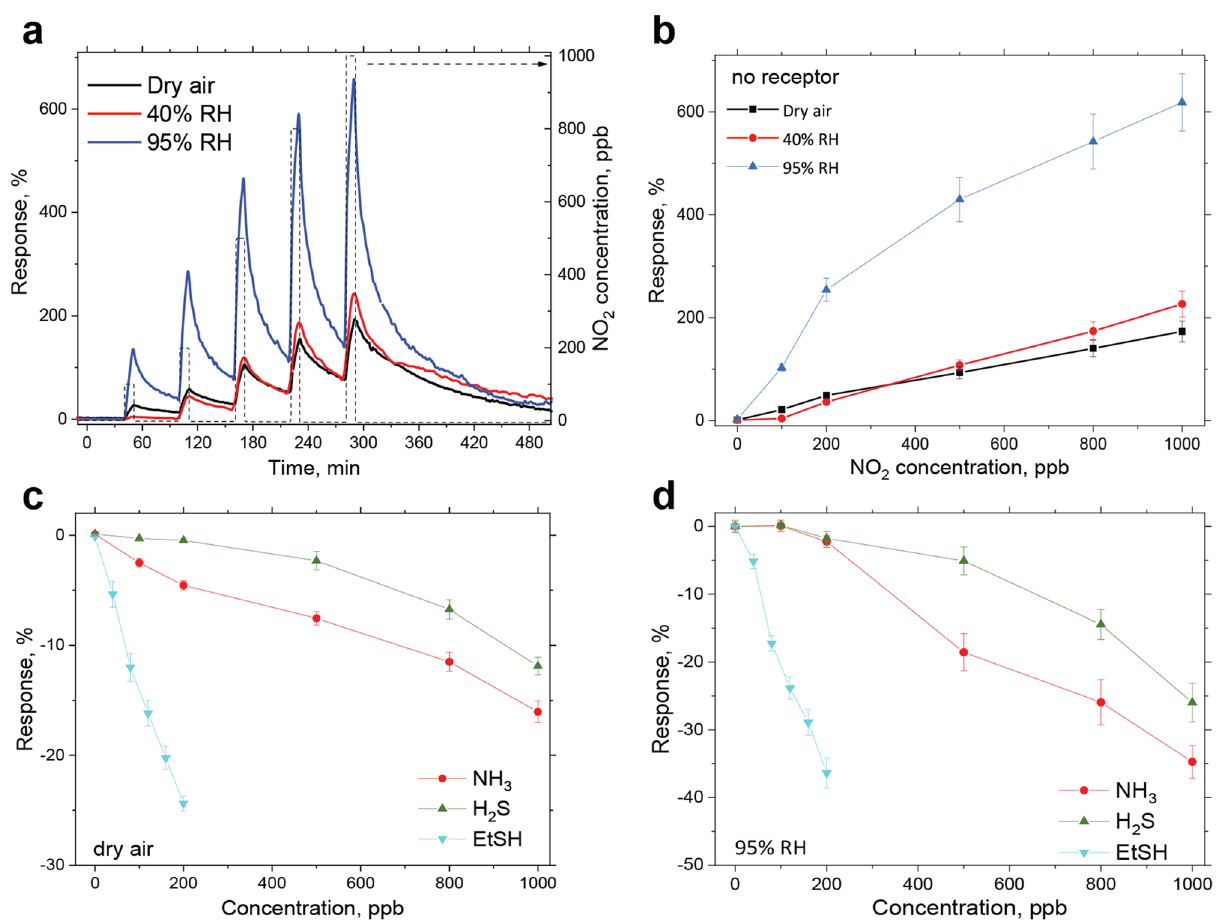
Figure 2. Properties of single OFET sensors without a receptor layer. ( a ) Dynamic sensor response to NO 2 pulses at 100, 200, 500, 800, 1000 ppb concentration in dry (black) and humid air at 40% (red) and 95% (blue) relative humidity. ( b ) Corresponding response curves. ( c , d ) Response curves of the sensors for target analytes: NH 3 , H 2 S, Et-SH and NO 2 in dry ( c ) and humid air at 95% RH ( d ). Mean values are presented with the standard